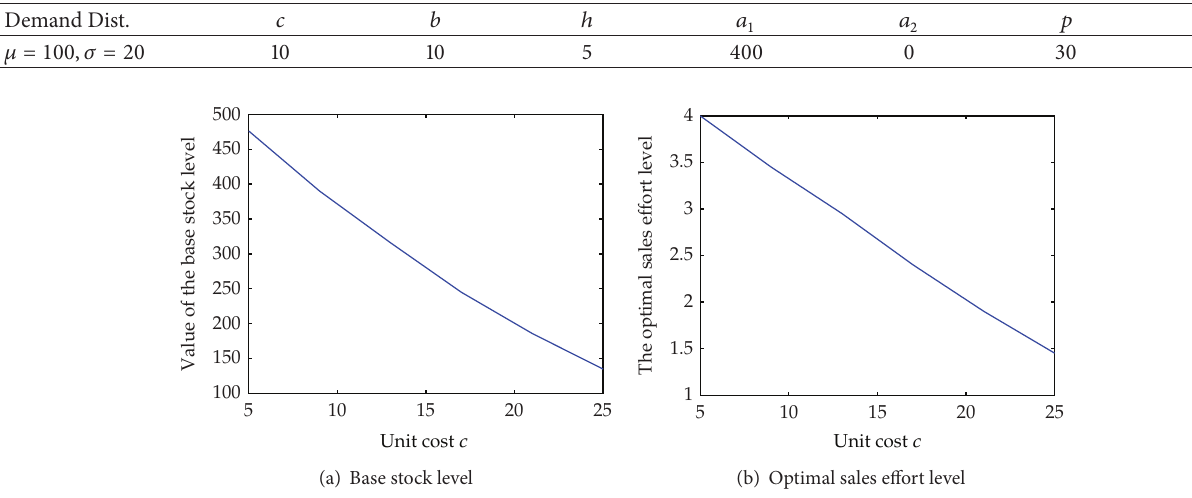
Figure 1: An illustration of the optimal policies with respect to unit